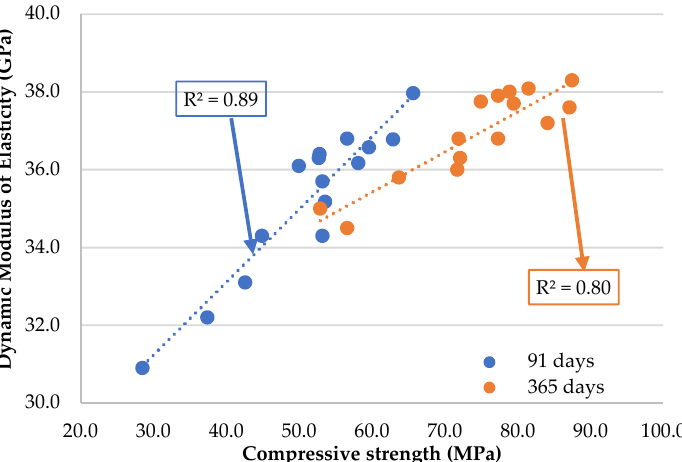
Figure 6. Dynamic modulus of elasticity at 91 and 365 days as a function of compressive strength (at